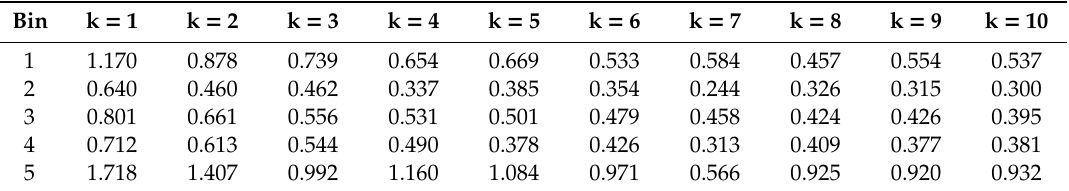
Table 9. MAE for PJM method.